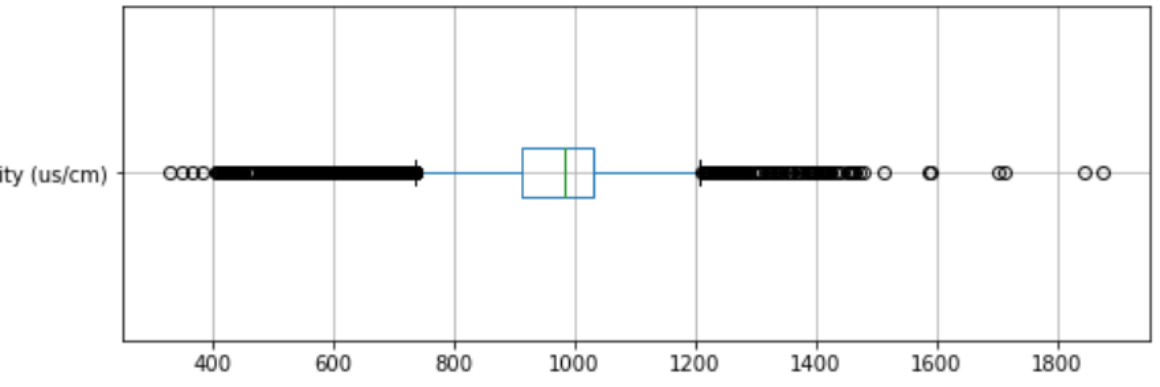
Figure 2. A boxplot showing conductivity outliers in The Cut.